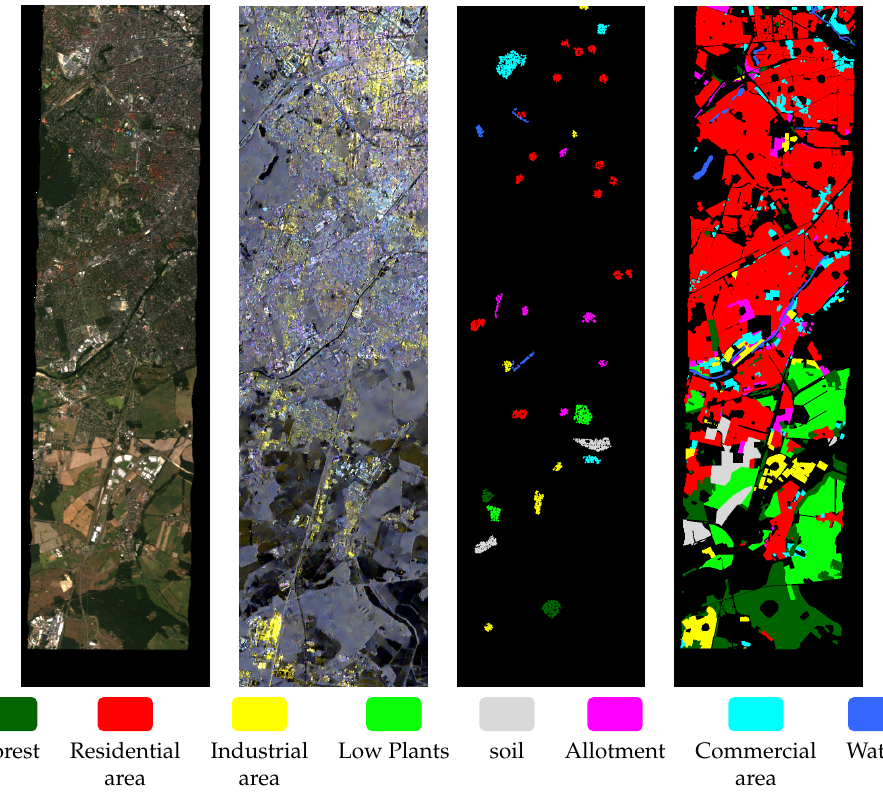
Figure 2. The Berlin data set. From left to right: RGB components of the simulated EnMAP data; Sentinel-1 dual-Pol data; The training data; The testing data.